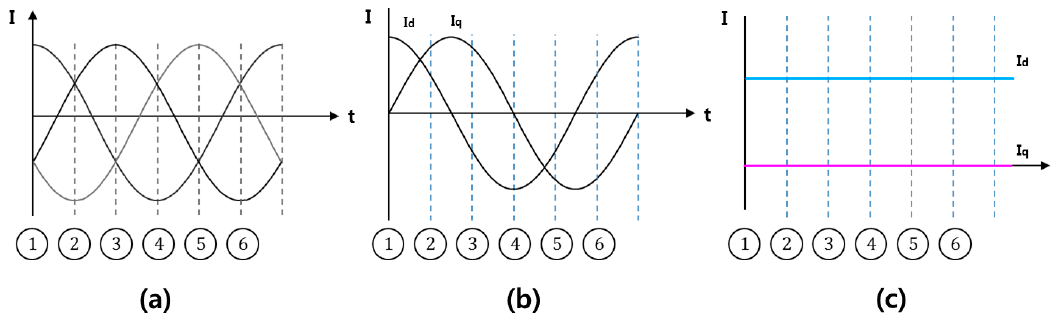
Figure 3. Current change due to D-Q transformation ( a ) 3-phase input current, ( b ) D-Q stationary coordinate system, ( c ) D-Q synchronous coordinate system.